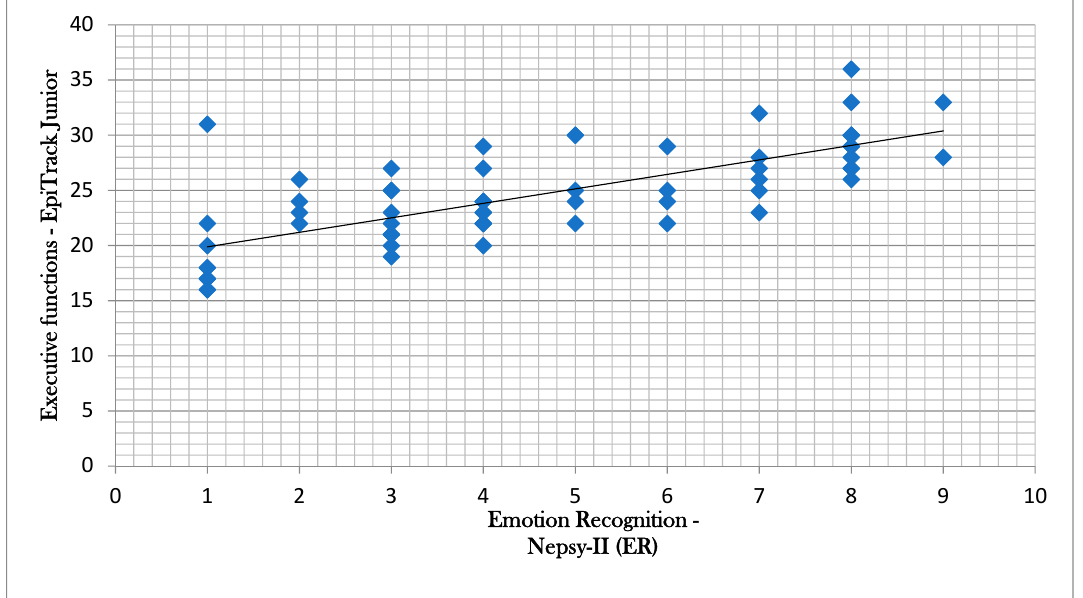
Figure 1. Correlation between Nepsy-II (Emotion Recognition) scores and EpiTrack Junior scores. The ER scores positively correlated also with the Working Memory Index (r = 0.569, p < 0.001) and the Processing Speed Index (r = 0.532, p < 0.001), while there was no significant correlation with the Verbal Comprehension Index (r = 0.009, p = 0.944) and the Perceptual Reasoning Index (r = − 0.121, p =